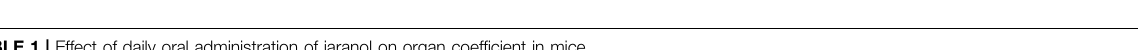
TABLE 1 | Effect of daily oral administration of jaranol on organ coef fi cient in mice.